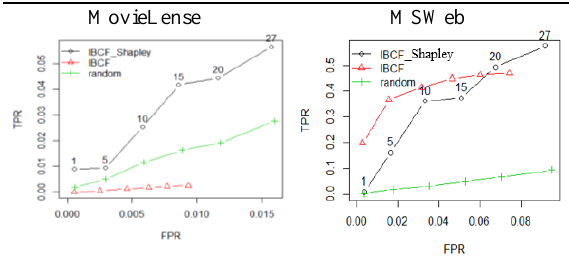
Figure 4. ROC curve of three models with k=25